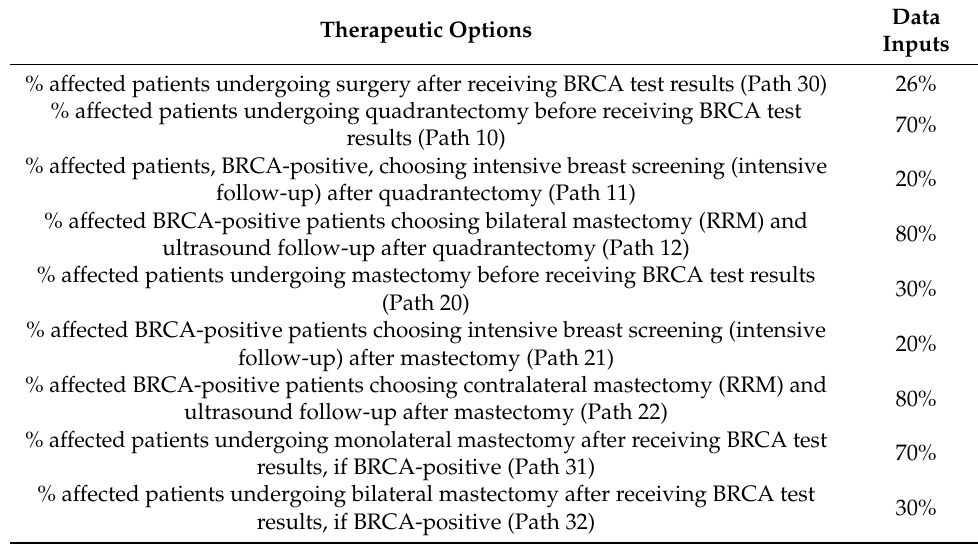
Table 2. Model input parameters: Probability of each therapeutic choice in the “as is” scenario. Therapeutic Options